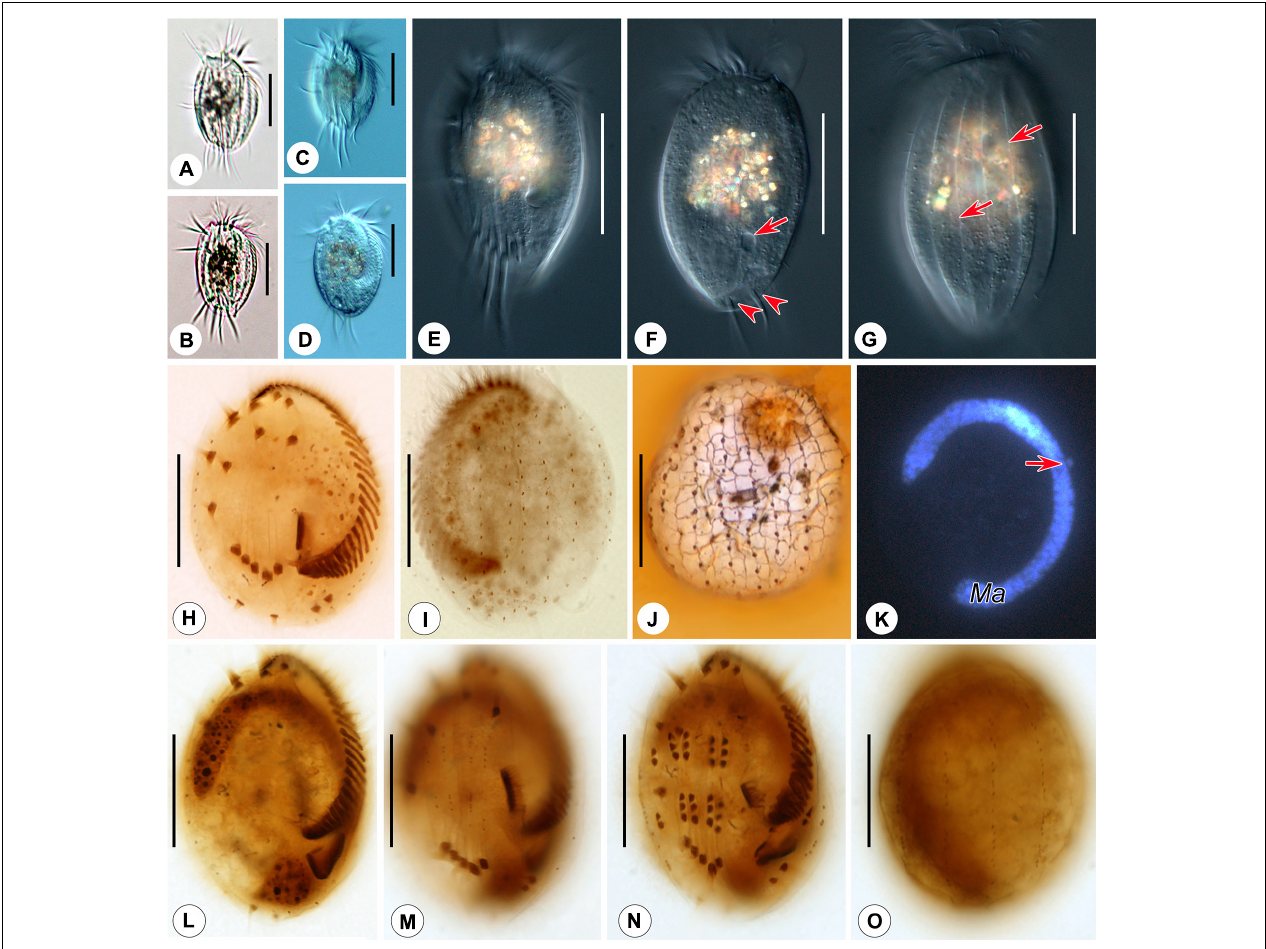
FIGURE 4 | Photomicrographs of Euplotes euryhalinus in vivo (A–G) , after protargol (H,I,L–O) , silver nitrate (J) , and DAPI staining (K) . (A–C) Ventral views of different cells, showing variation in body shape. (D) Ventral view, showing contractile vacuole. (E) Ventral view, showing conspicuous ridges. (F,G) Dorsal view, showing contractile vacuole (arrow in F ), caudal cirri (arrowheads), and the dominant dorsal ridges (arrows in G ). (H,I) Ciliature of ventral (H) and dorsal (I) sides of the same specimen. (J) Silverline system on the dorsal side. (K) C-shaped macronucleus and micronucleus (arrow). (L,M) Ventral view of the same early divider, showing oral primordium in opisthe and cirral anlagen. (N,O) Ventral (N) and dorsal (O) view of the same middle divider, showing the development of oral primordium, cirral, and dorsal anlagen. Bars, 25 µ